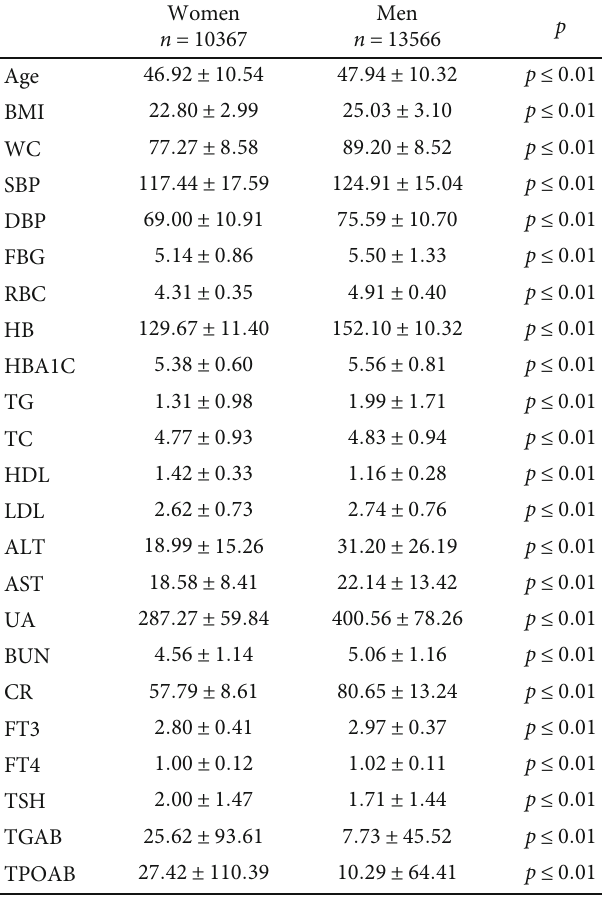
Table 1: Comparison of baseline data between men and women. Women n =